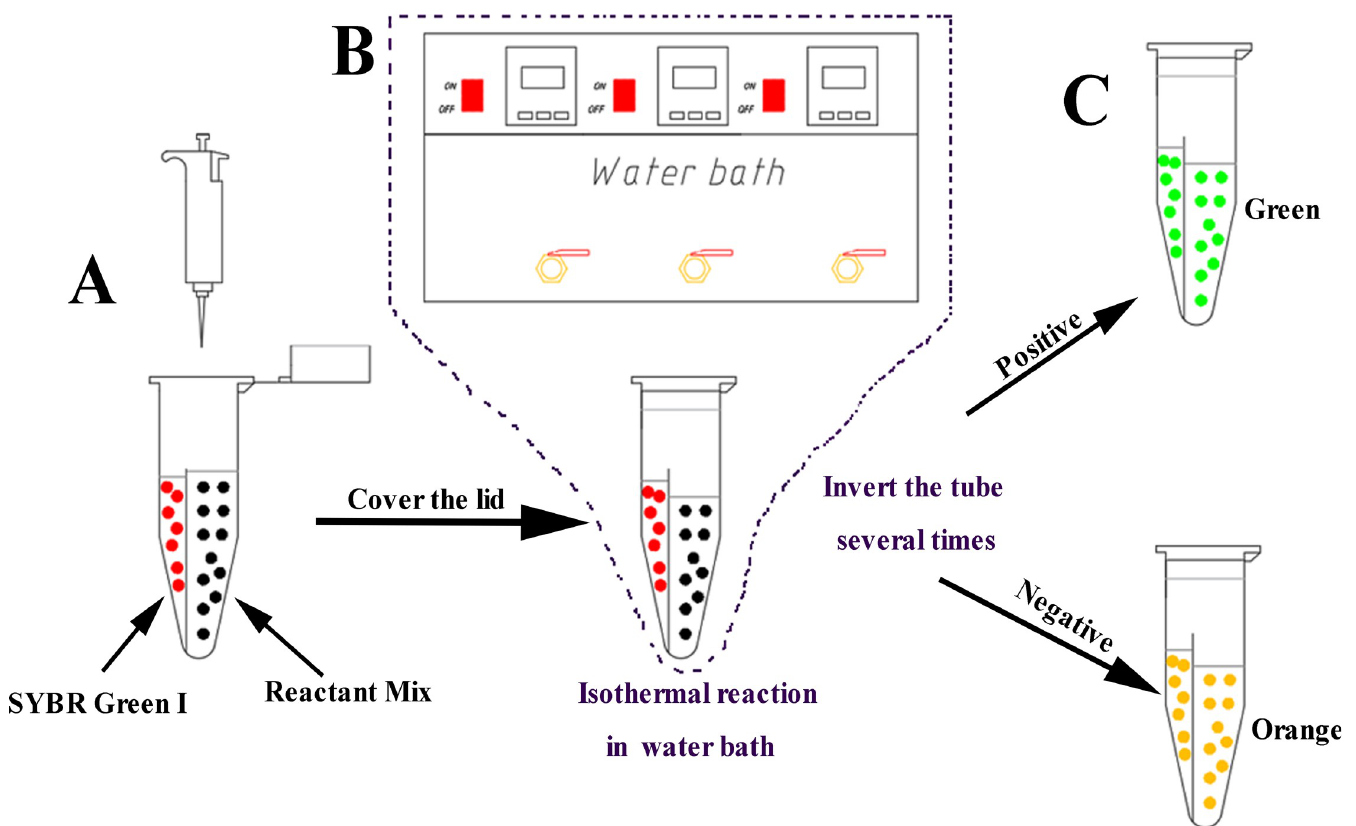
Fig 3. Schematic diagram of all isothermal reaction steps. A, SYBR Green I and the reaction mixture were added into a Hua-Feng tube (Guangzhou Hua-feng Biological Technology Co.,Ltd), respectively. B, Incubation at constant temperature for a period of time (45–90 min). C, Result determination.